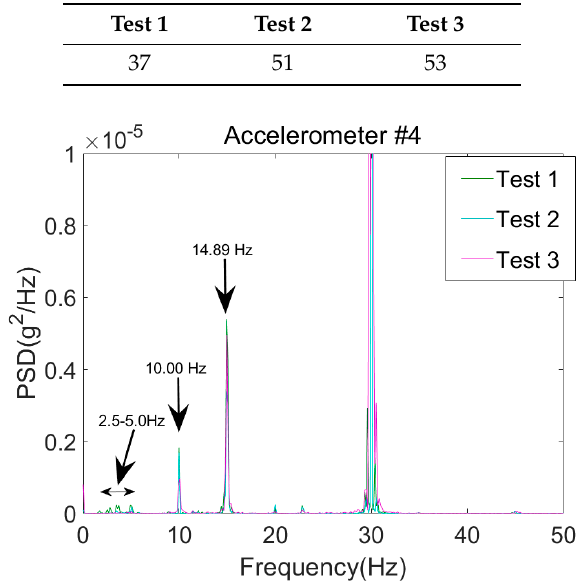
Figure 17. Acceleration spectra for the vehicle sensor.